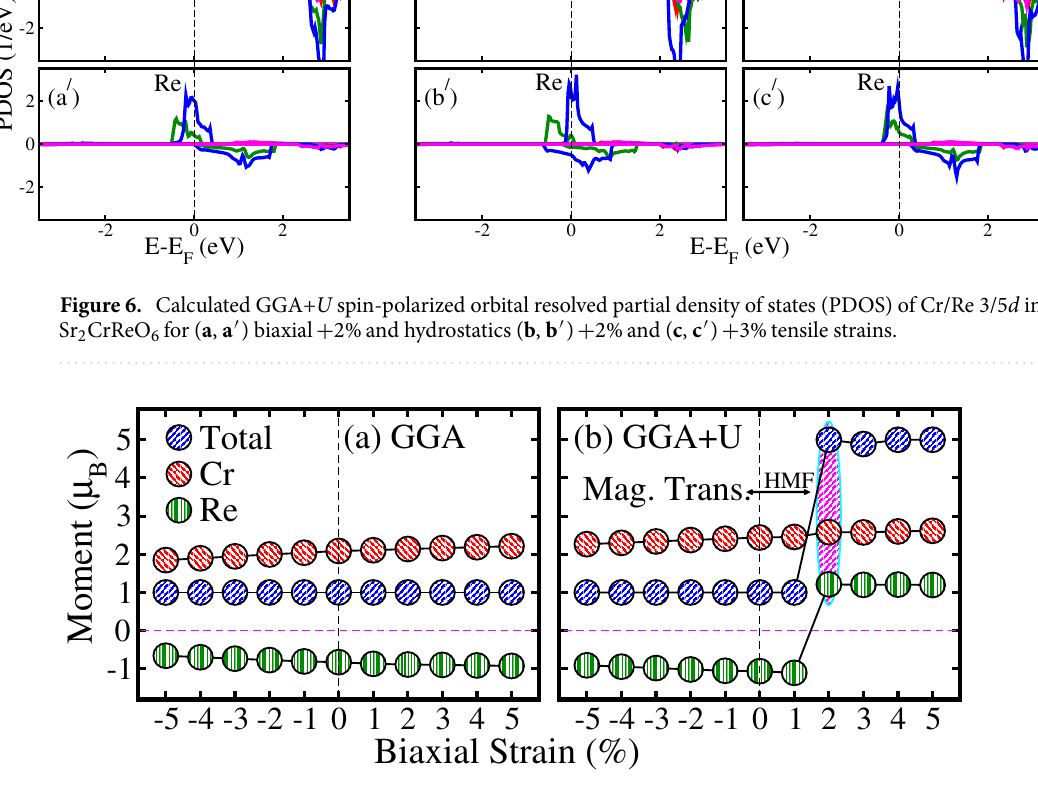
Figure 7. Calculated total and partial magnetic moments of Sr 2 CrReO 6 within ( a ) GGA and ( b ) GGA+ U schemes as a function of biaxial strains along the [110]-direction. The “−” and “ + ” signs indicate compressive and tensile strains, respectively. The shaded region (magenta color in b ) represents the magnetic transition from half-metallic ferri-(HM FiM) to half-metallic ferromagnetic (HMF)